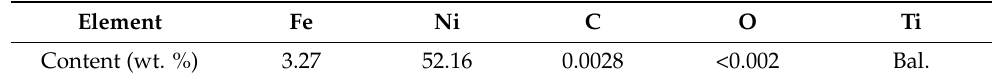
Table 1. Chemical compositions of TiNiFe alloys.